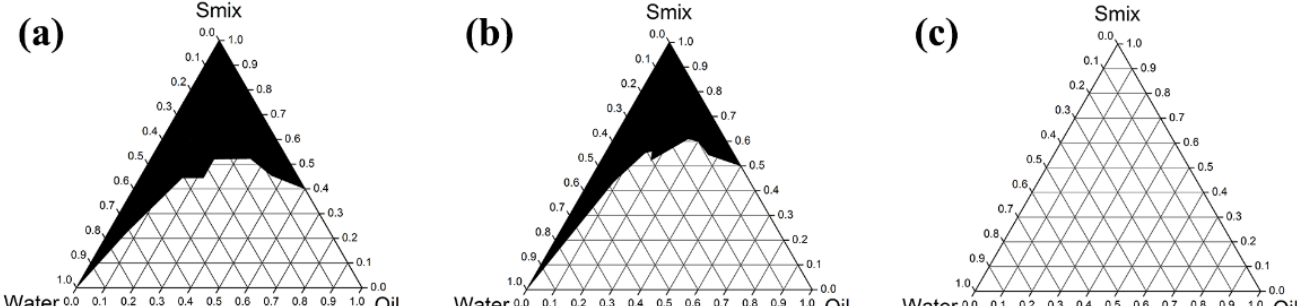
Figure 5. Pseudoternary phase diagrams of AGO/Tween ® 20/co-surfactant/water when the co- surfactants were ethanol ( a ), propan-2-ol ( b ), PG ( c ), glycerin ( d ), PEG 400 ( e ) and PEG 600 ( f ). Table 2. Dielectric constant (δ) of co-surfactant at 20 °C. Figure 6. Pseudoternary phase diagrams of AGO/Tween ® 20/PG/water when the Tween ® 20/PG ratios were 4:1 ( a ), 1:1 ( b ), and 1:4 ( c ). Table 3. Internal droplet size and PDI of AGO microemulsion before and after the stability test.